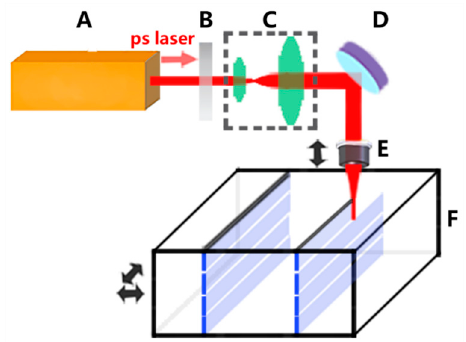
Figure 1. Schematic diagram of experimental setup for laser dicing. A: picosecond laser system; B: attenuator; C: beam expander; D: reflective mirror; E: objective lens; F: lithium niobate (LiNbO 3 ) sample.